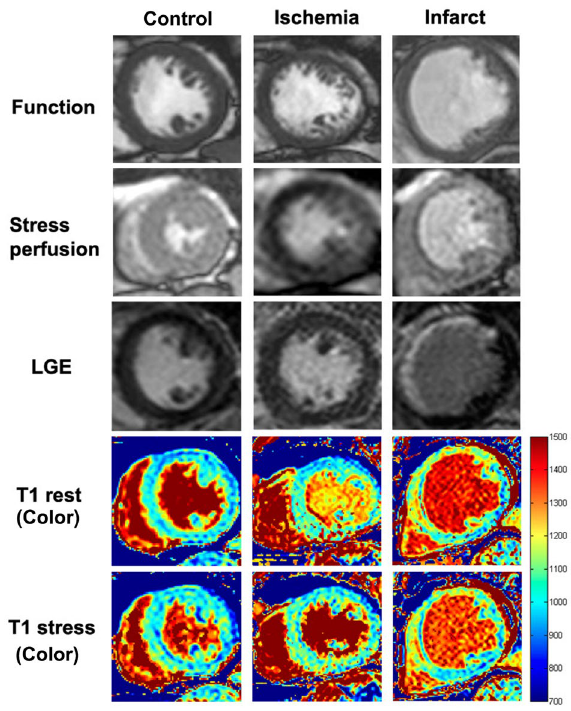
Figure 2. CMR images of function (top panel), stress perfusion (2nd panel), LGE (3rd panel), color map of T1 at rest and stress (4th and 5th panel). The control group (left) showed normal perfusion with no late-gadolinium enhancement (LGE). The ischemic patient (middle) showed first-pass perfusion defect at the septal wall without LGE. The infarcted patient (right) showed first-pass perfusion defect and positive LGE at the anterior and septal walls.